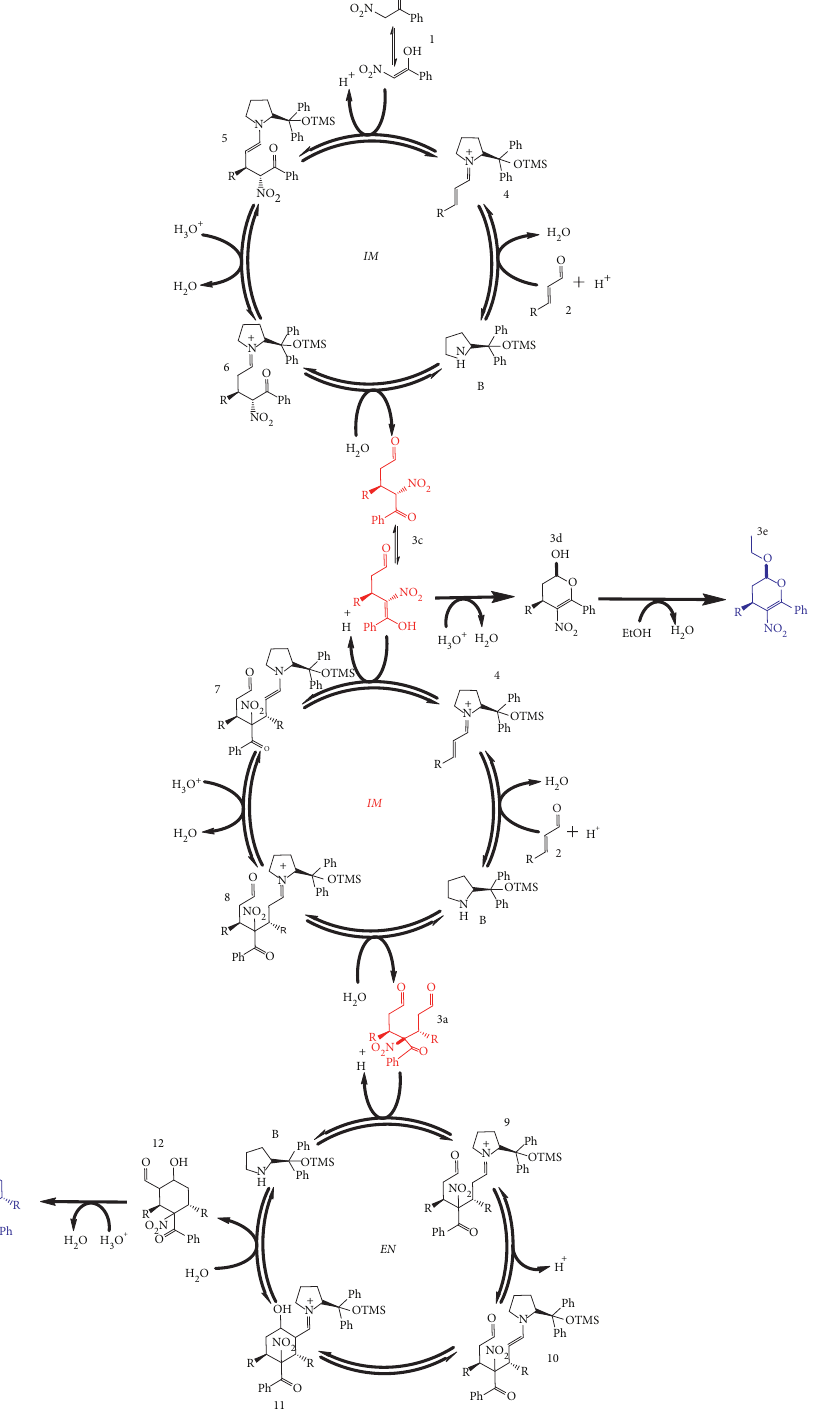
Scheme 4: Proposed mechanism for the organocatalytic synthesis of 3a , 3b , 3c , 3d , and 3e